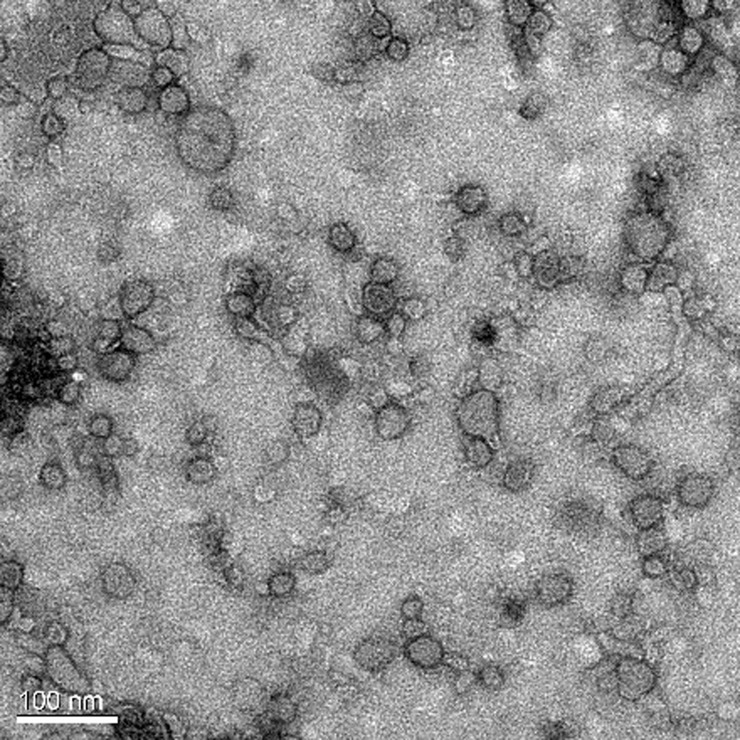
Transmission electron microscope image of recombinant Apxr-OMVs.The bar indicates 100 nm.